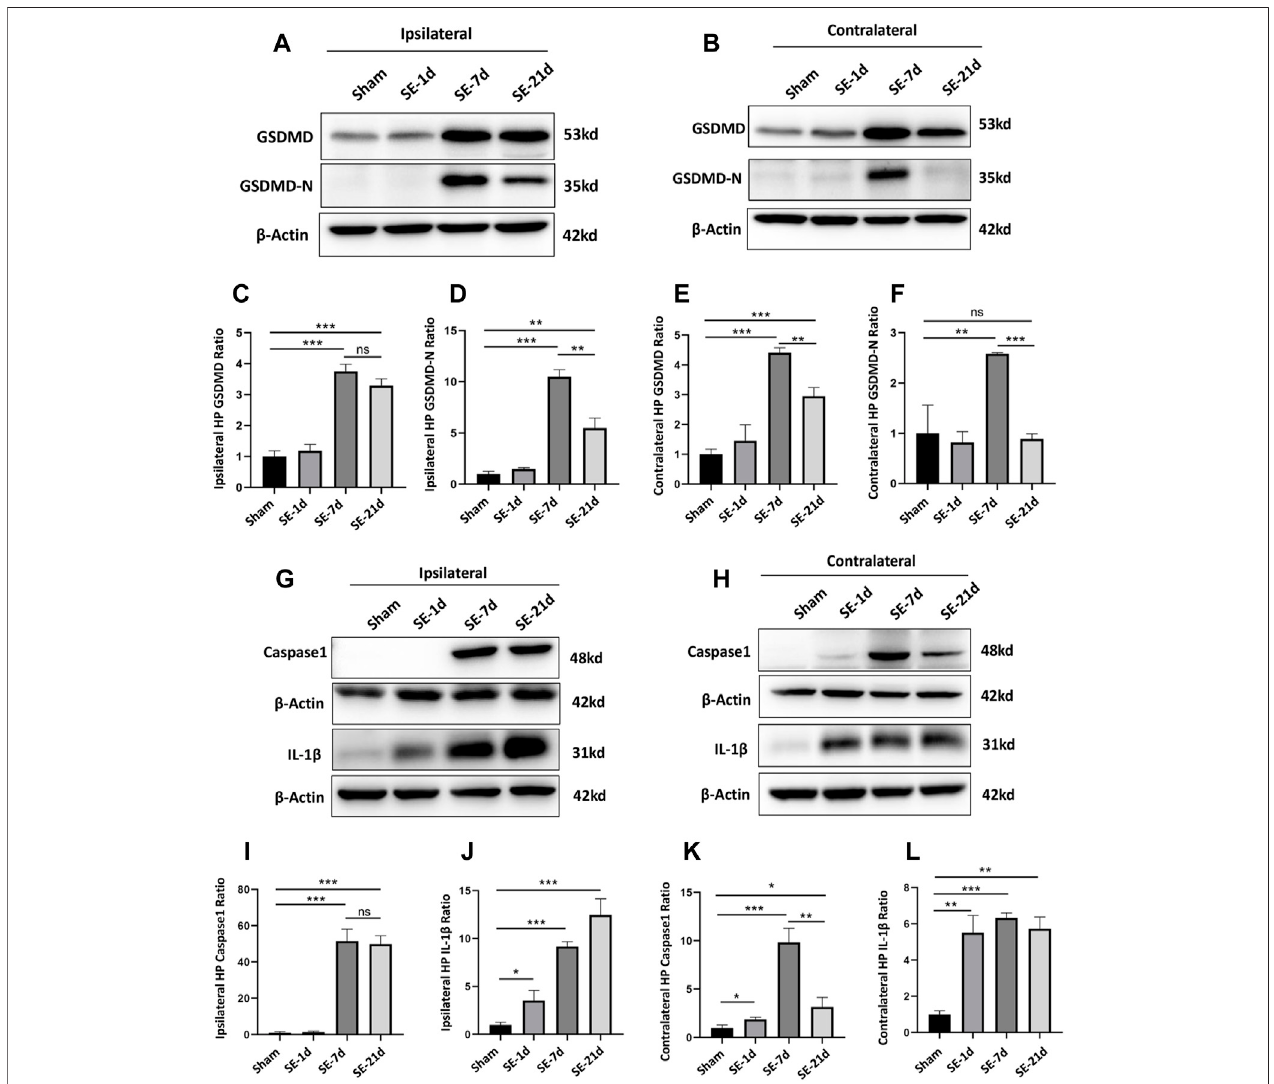
FIGURE 1 | Expression of GSDMD and pyroptosis-related molecules was signi fi cantly increased after kainic acid-induced SE. (A,B) WB bands of GSDMD, GSDMD-N, and β -actin proteins in the ipsilateral and contralateral hippocampus. (C – F) Statistical analyses of GSDMD, GSDMD-N, and β -actin proteins in the ipsilateral and contralateral hippocampus. (G,H) WB bands of caspase-1, IL-1 β , and β -actin proteins in the ipsilateral and contralateral hippocampus. (I – L) Statistical analyses of caspase-1, IL-1 β , and β -actin proteins in the ipsilateral and contralateral hippocampus ( n = 3 in each group, * p < 0.05, ** p < 0.01, and *** p < 0.001).